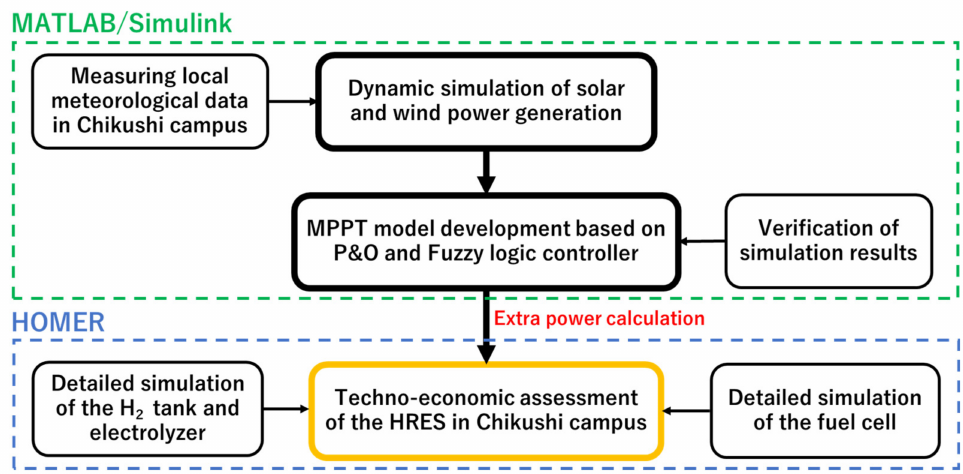
Figure 3. Research flow in this paper.